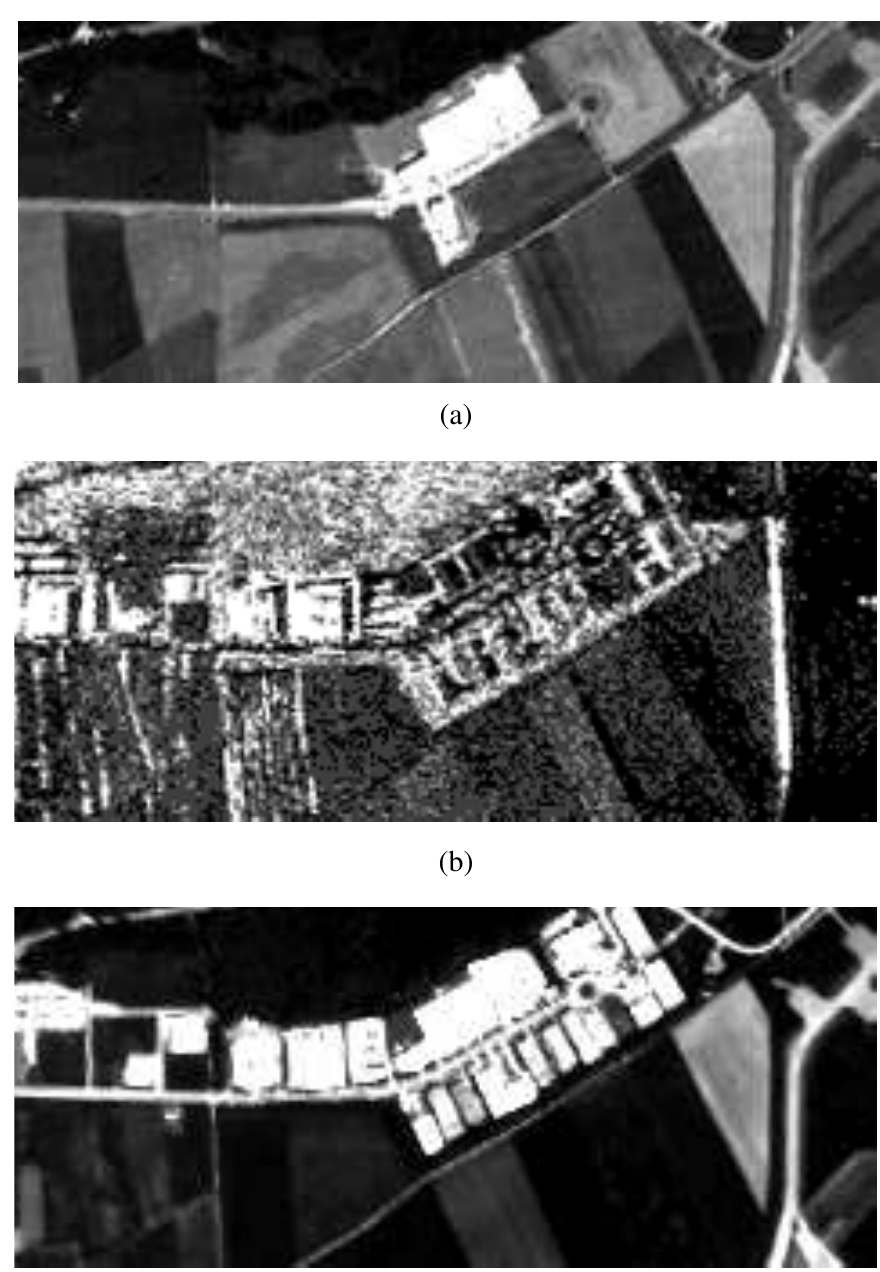
Figure 7. Oberpfaffenhofen data set: (a) panchromatic, (b) SAR and (c) HS